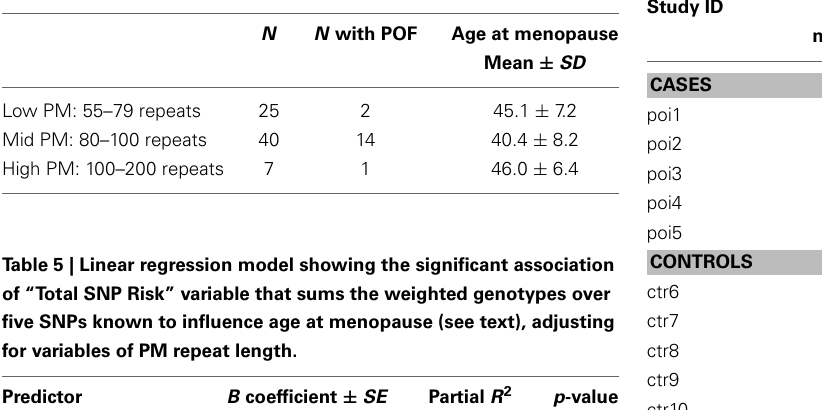
Table 4 | Study sample used to examine the association of common SNPs reported to influence normal age at menopause.